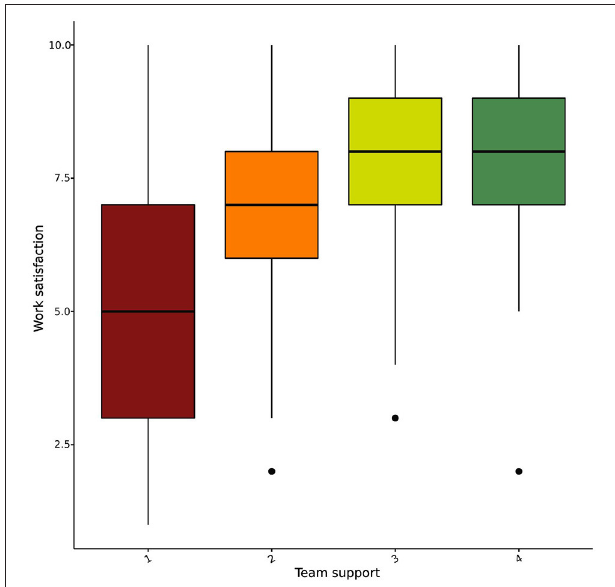
FIGURE 5 | Job satisfaction grouped by the level of team support experienced by pediatricians.